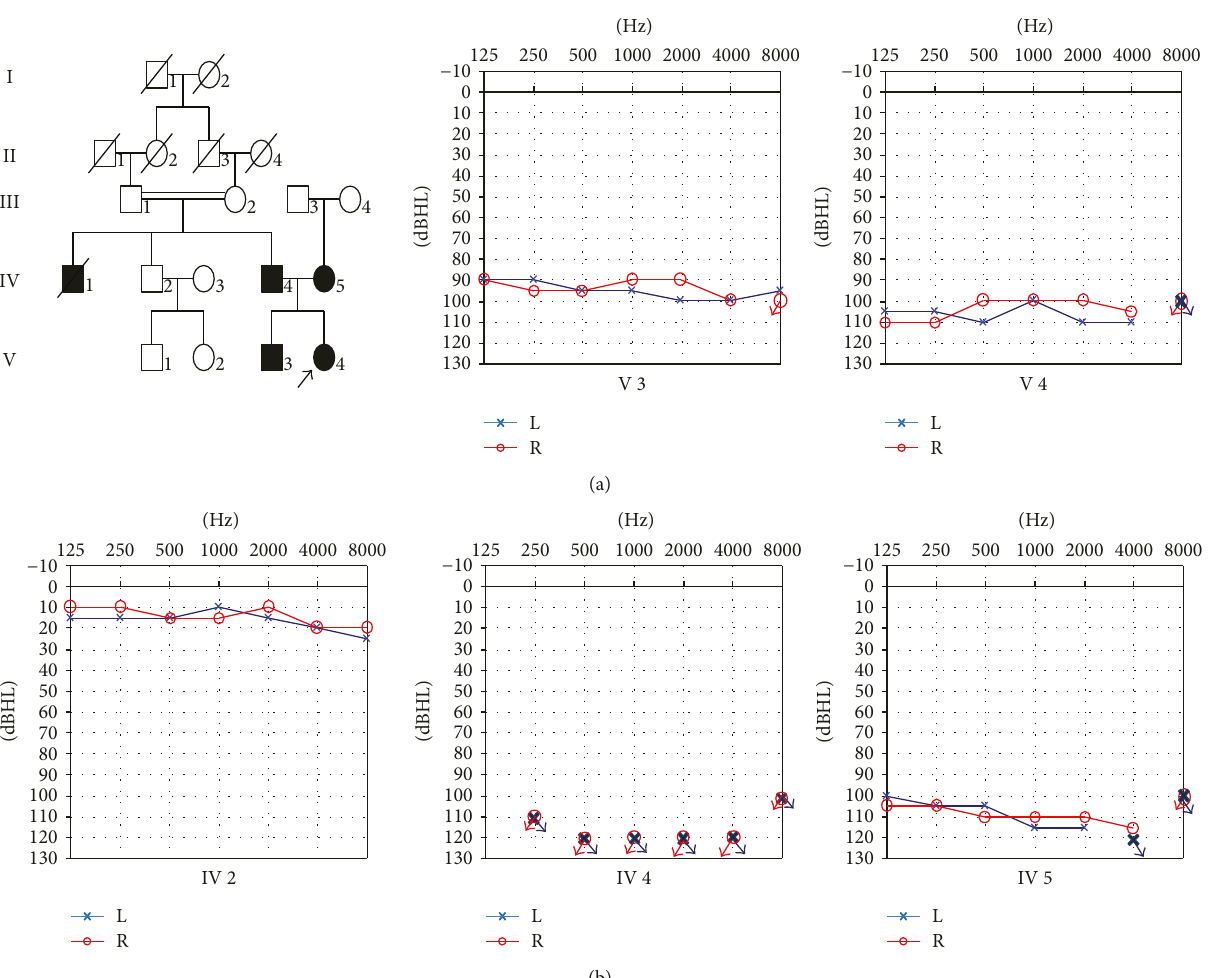
Figure 1: Clinical phenotype presentations of the pedigree. (a) Disease presentation of the family members and the pedigree map. All living members participated in the study, and V-3, V-4, and IV-2 were sequenced using capture gene sequencing. (b) Pure-tone audiograms of the family. Frequency in hertz (Hz) is plotted on the x -axis and the hearing level in decibels (dBHL) on the y -axis. The arrows in blue or red mean that the pure tones are not elicited at this